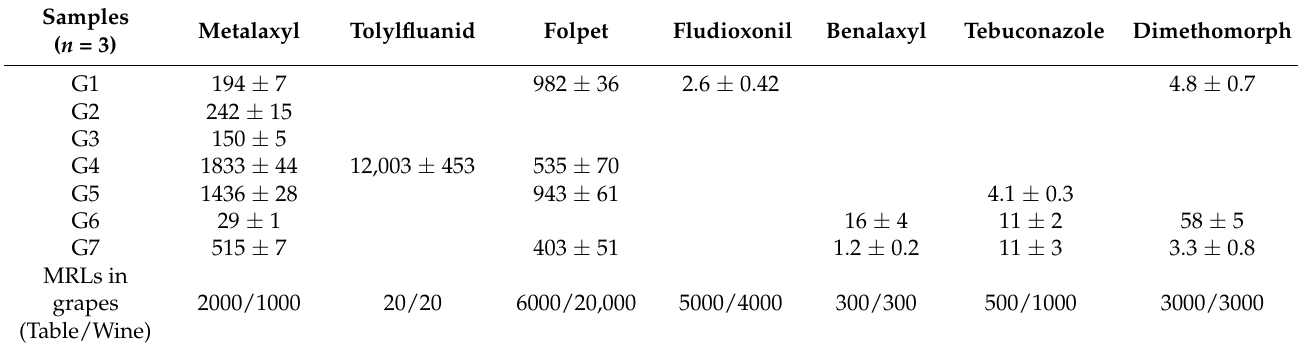
Table 4. Concentration ± SD (ng g − 1 ) of the target fungicides in grape samples by UAE-GC-MS/MS.